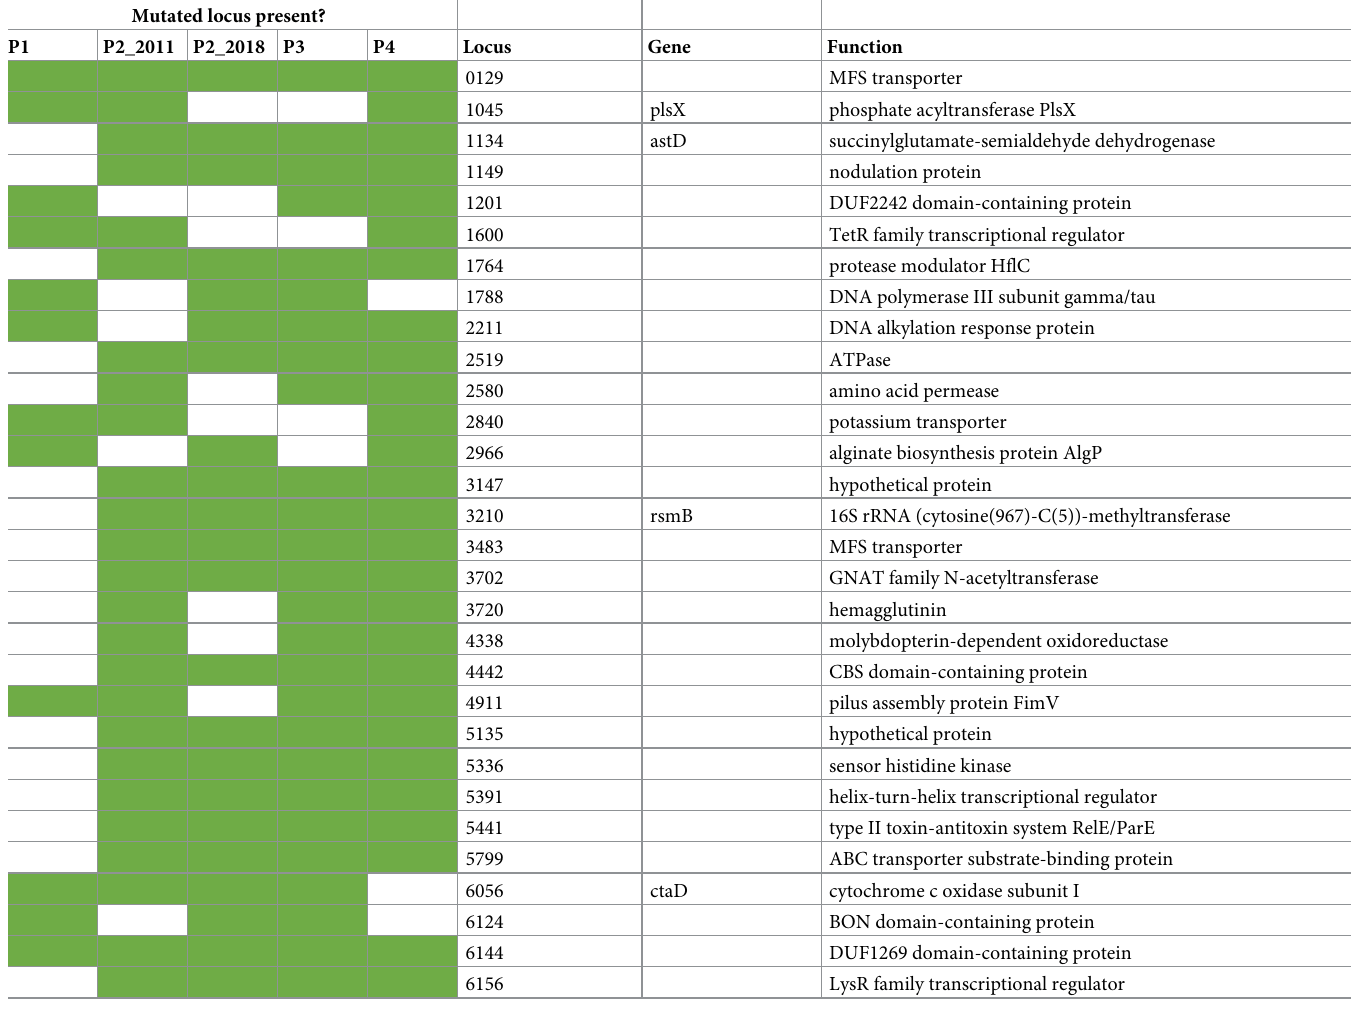
Table 4. Loci undergoing parallel evolution in patients 1–4. List of 30 locus with mutations (SNPs) in at least three patients (see also Table I in S1 Tables). We separated the isolates from 2011 and the isolate from 2018 in patient 2 as we regard them as two separate acquisition events. Mutated locus